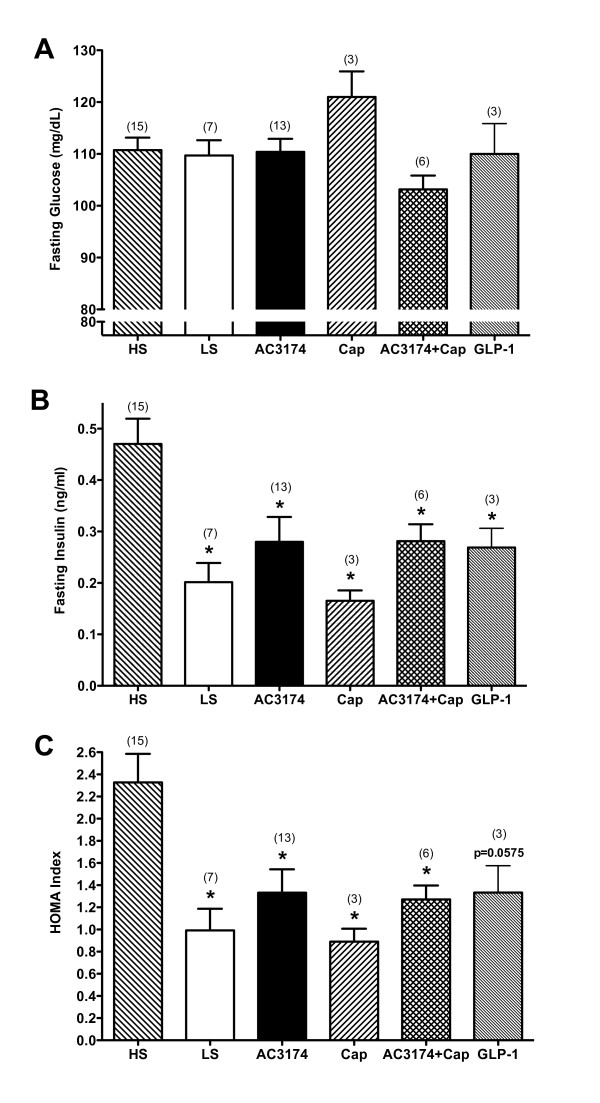
Beneficial effects of AC3174 on fasting glycemic control after 4 weeks of treatment. (A) Fasting serum glucose concentrations. No significant differences among groups. (B) Fasting serum insulin concentrations. P = 0.0020 for one-way ANOVA. The pooled-over-time means of the low salt, AC3174, and captopril groups were significantly different from the high salt group (P ≤ 0.05). (C) HOMA. P = 0.0014 for one-way ANOVA. The pooled-over-time means for all treatment groups except GLP-1 were significantly different from the high salt group (P ≤ 0.05).